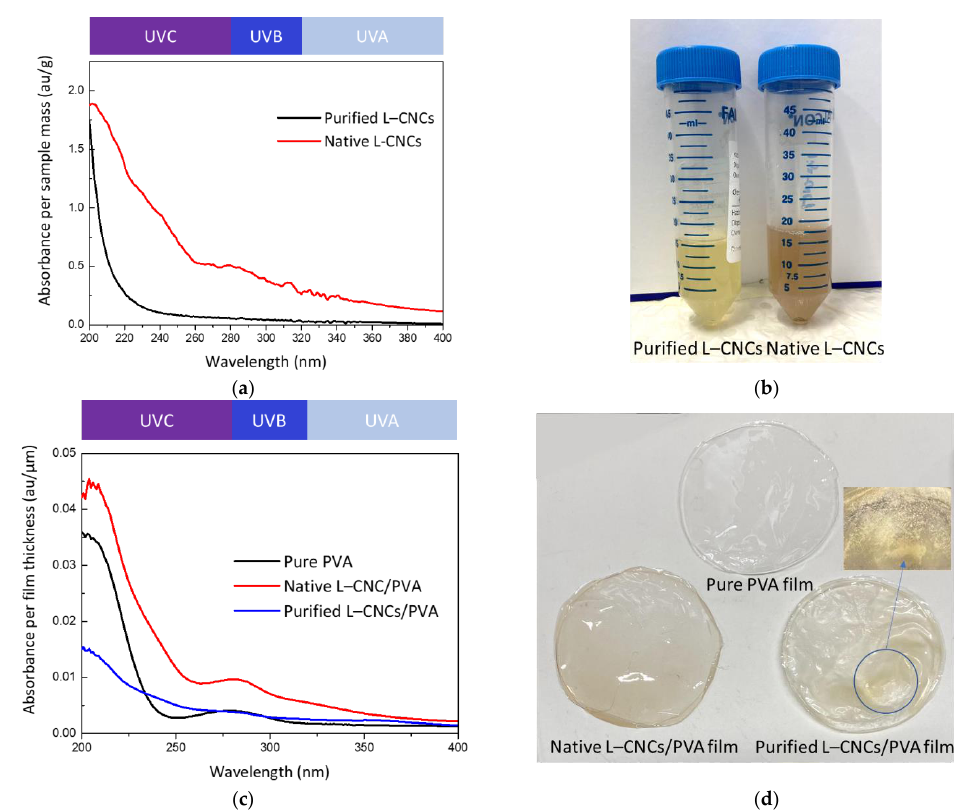
Figure 3. UV absorption ( a ) and a digital image of ( b ) purified L – CNCs and native L – CNCs solution, ( c ) the UV absorption (normalised by the film thickness) and a digital image of ( d ) of purified L – CNCs film and native L – CNCs film. The black background was used to enhance the contrast, while showing the enlarged part of the purified L – CNCs/PVA. Table 2. Transmittance and normalised ultraviolet protection factor (UPF) of pure PVA, native L–CNCs/PVA and purified